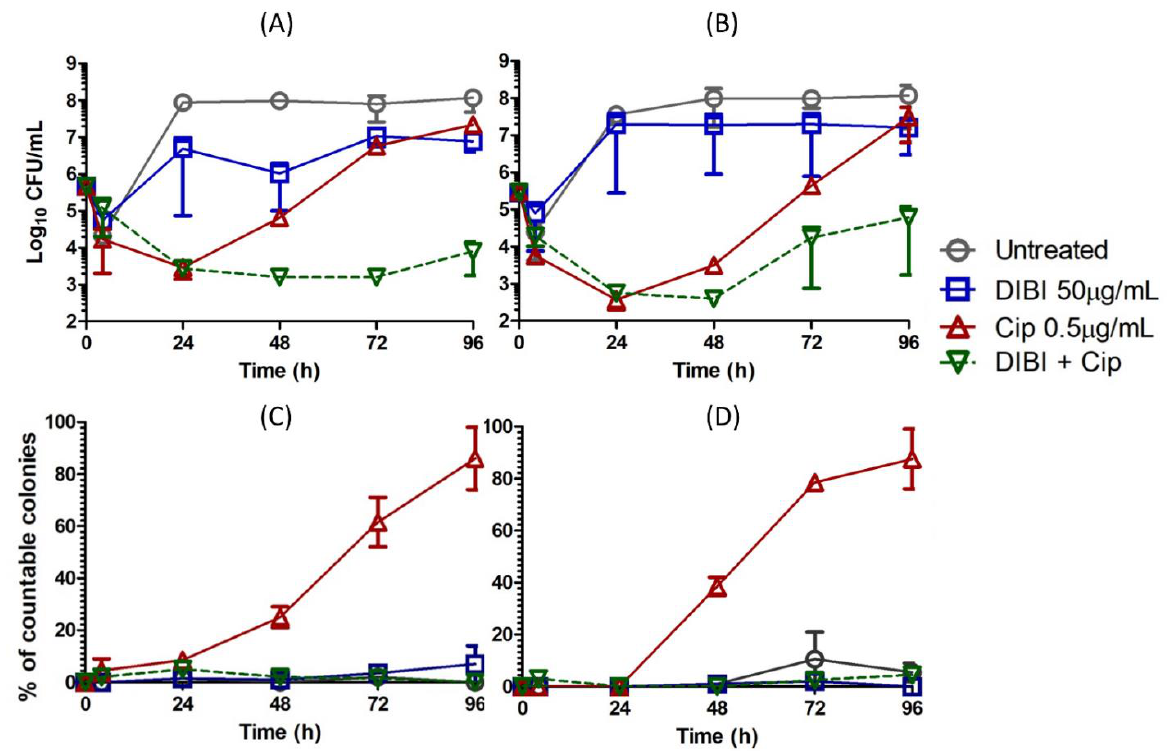
Figure 3. Effects of ciprofloxacin and DIBI on Staphylococcus aureus killing and small colony variant recovery growth. S. aureus ATCC 43300 ( A , C ) and ATCC 25923 ( B , D ) were grown in MHB and a standardized inoculum added to 10 mL flask cultures of untreated RPMI control (o), or RPMI with added 50 µ g/mL DIBI ( (cid:3) ), 0.5 µ g/mL CIP ( ∆ ) or 50 µ g/mL DIBI combined with 0.5 µ g/mL CIP ( (cid:53) ). Samples taken during exposure were plated onto BA for enumeration of total CFU/mL ( A , B ) and the percentage of SCVs ( C , D ) in the recovered populations. The data represent means ± SEM for two independent experiments.